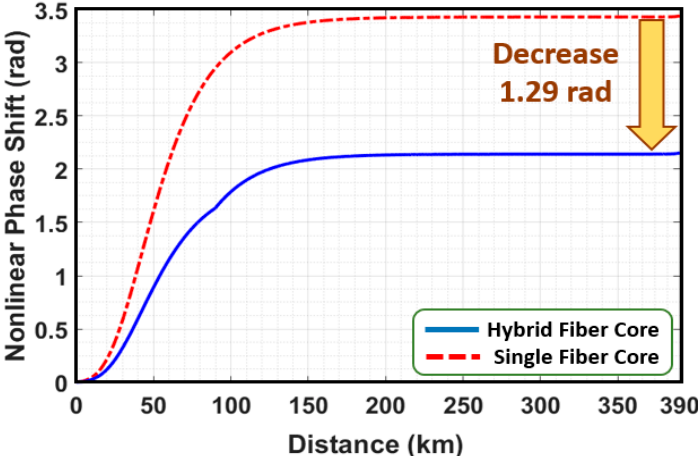
Figure 5. Nonlinear phase shift of the three-segment hybrid fiber core structure compared to the conventional single fiber core structure. The hybrid fiber core structure has a lower SPM-induced nonlinear phase shift, which helps to reduce nonlinear signal distortion.